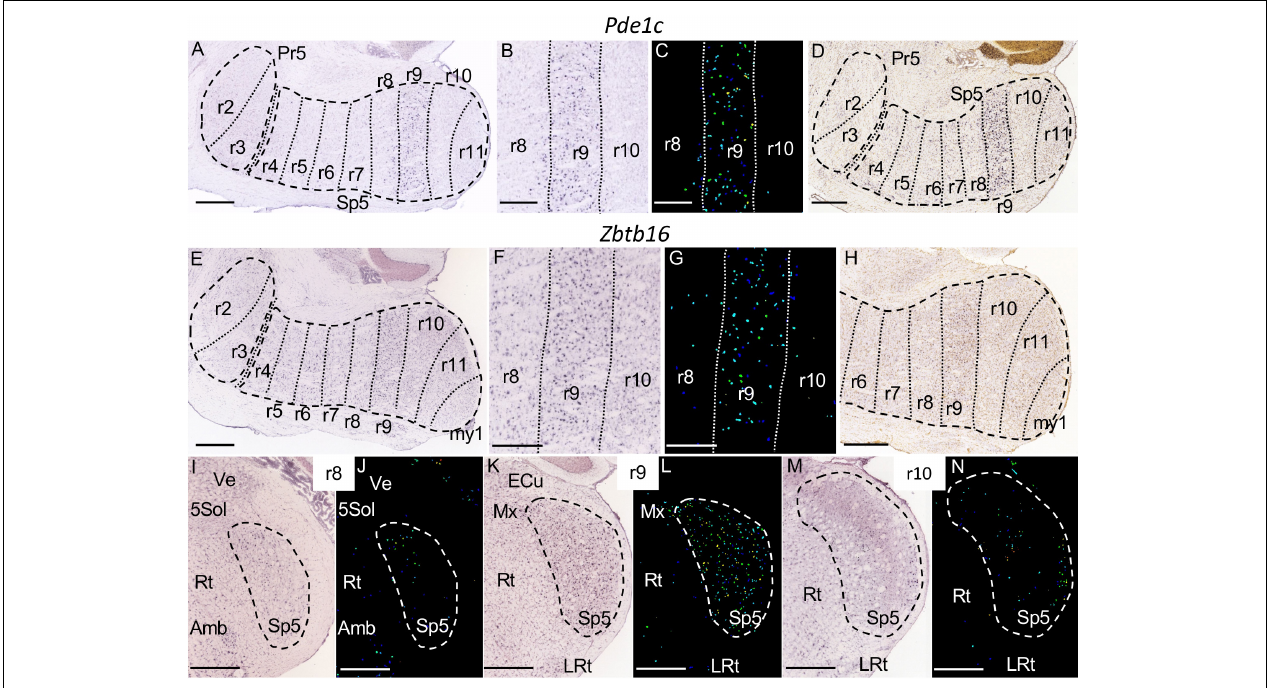
FIGURE 11 | Pde1c (A–D) an Zbtb16 (E–N) expression. (A) Brightfield image of a parasagittal section of an adult brain processed for Pde1c detection, showing specific expression in the r9 portion of Sp5. (B,C) Magnification detail of the latter image, together with its color-coded counterpart, centered in r9. (D) Brightfield image of a parasagittal section from a P28 brain, showing the aforementioned expression pattern for Pde1c . (E) Brightfield image of a parasagittal section of an adult brain processed for Zbtb16 detection, showing specific expression in the r9 portion of Sp5. (F,G) Magnification detail of the latter image, together with its color-coded counterpart, centered in r9. (H) Brightfield image of a parasagittal section from a P28 brain, showing the aforementioned expression pattern for Zbtb16 . (I–N) Pairs of brightfield and color-coded images of respective coronal sections of an adult brain at the levels of r8, r9, and r10. Note the specific expression of Zbtb16 in the r9 portion of Sp5, as compared to few positive cells in the r8 and r10 portions of this nucleus. Other structures close to Sp5 -external cuneatus nucleus (ECu), Ve, 5Sol, Rt, Amb and LRt- are indicated as reference landmarks. (A,D,E,H–N) Scale bars = 500 µ m; (B,C,F,G) scale bars = 300 µ